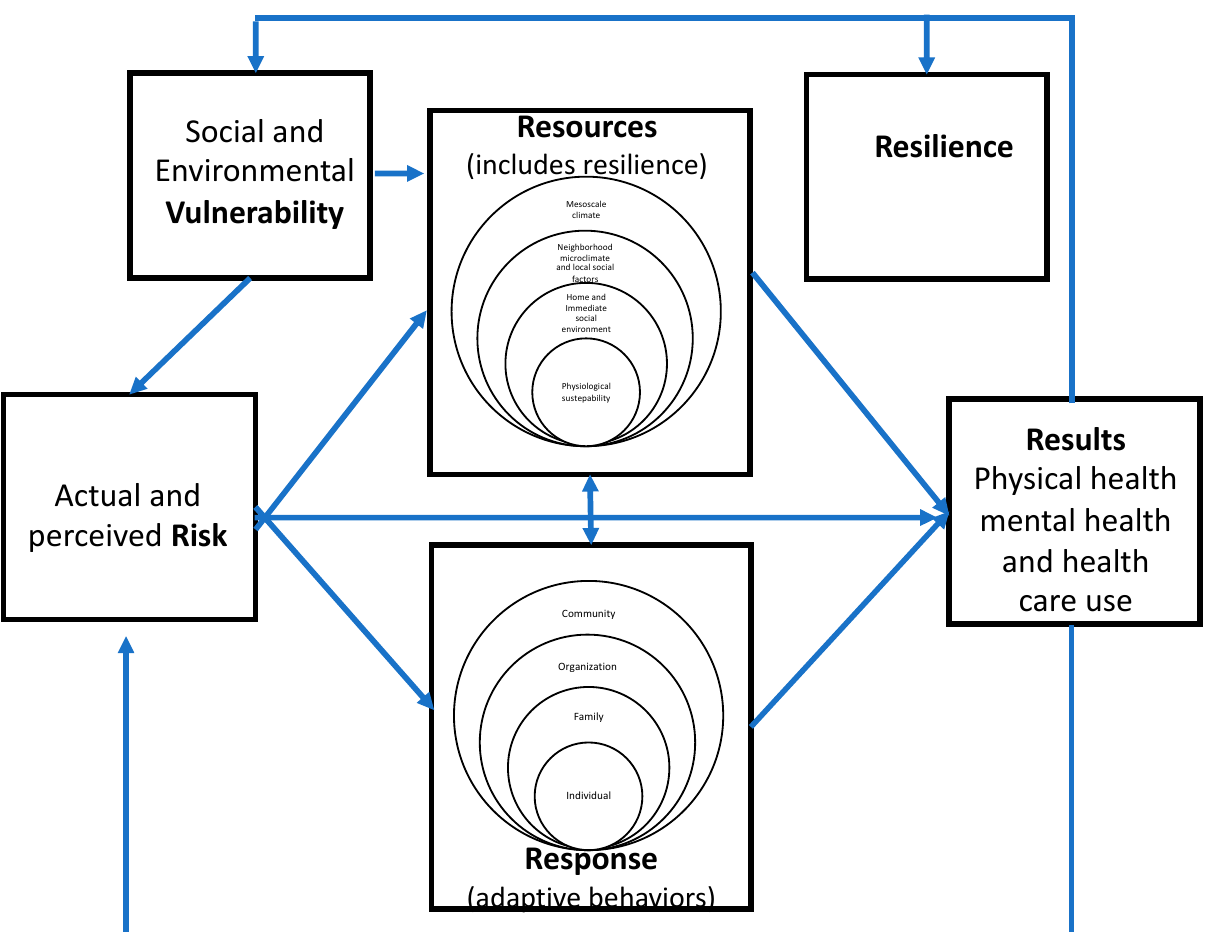
Figure 1. The 4R integrated model of heat wave adaptation.